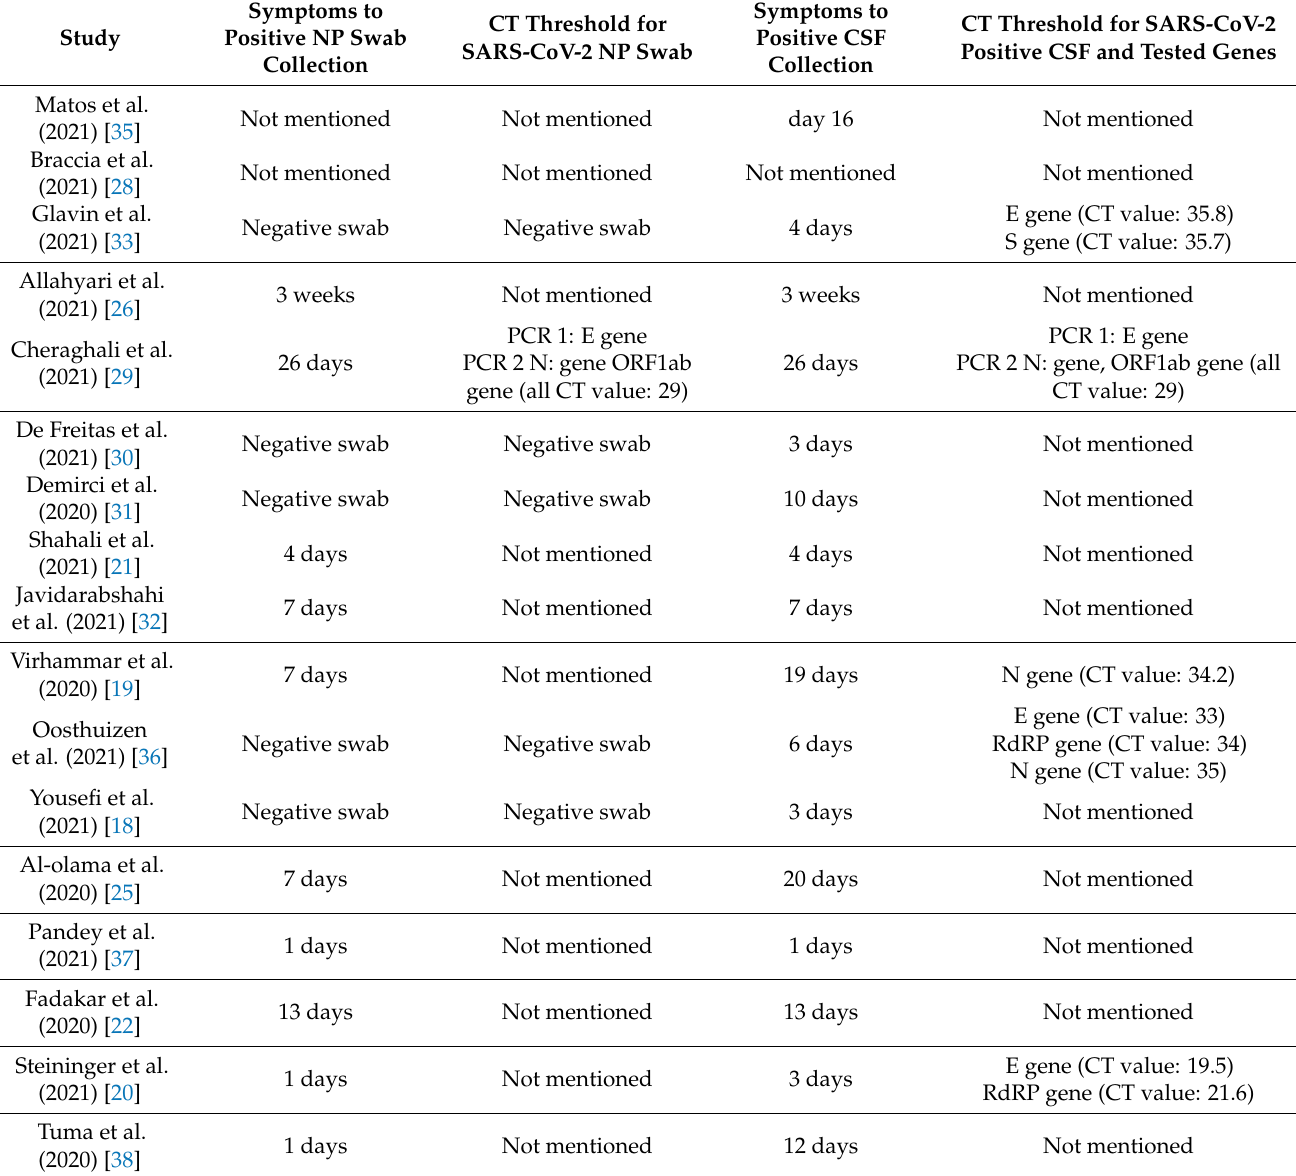
Table 2. Time from onset of symptoms to SARS-CoV-2 testing with reported CT thresholds and genes